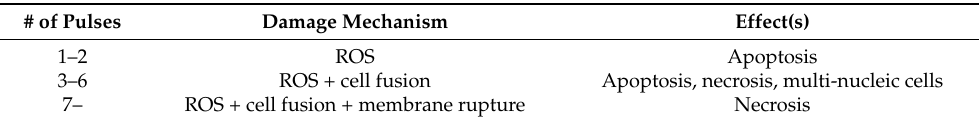
Table 3. Effect of irradiating femtosecond pulses on cell fate